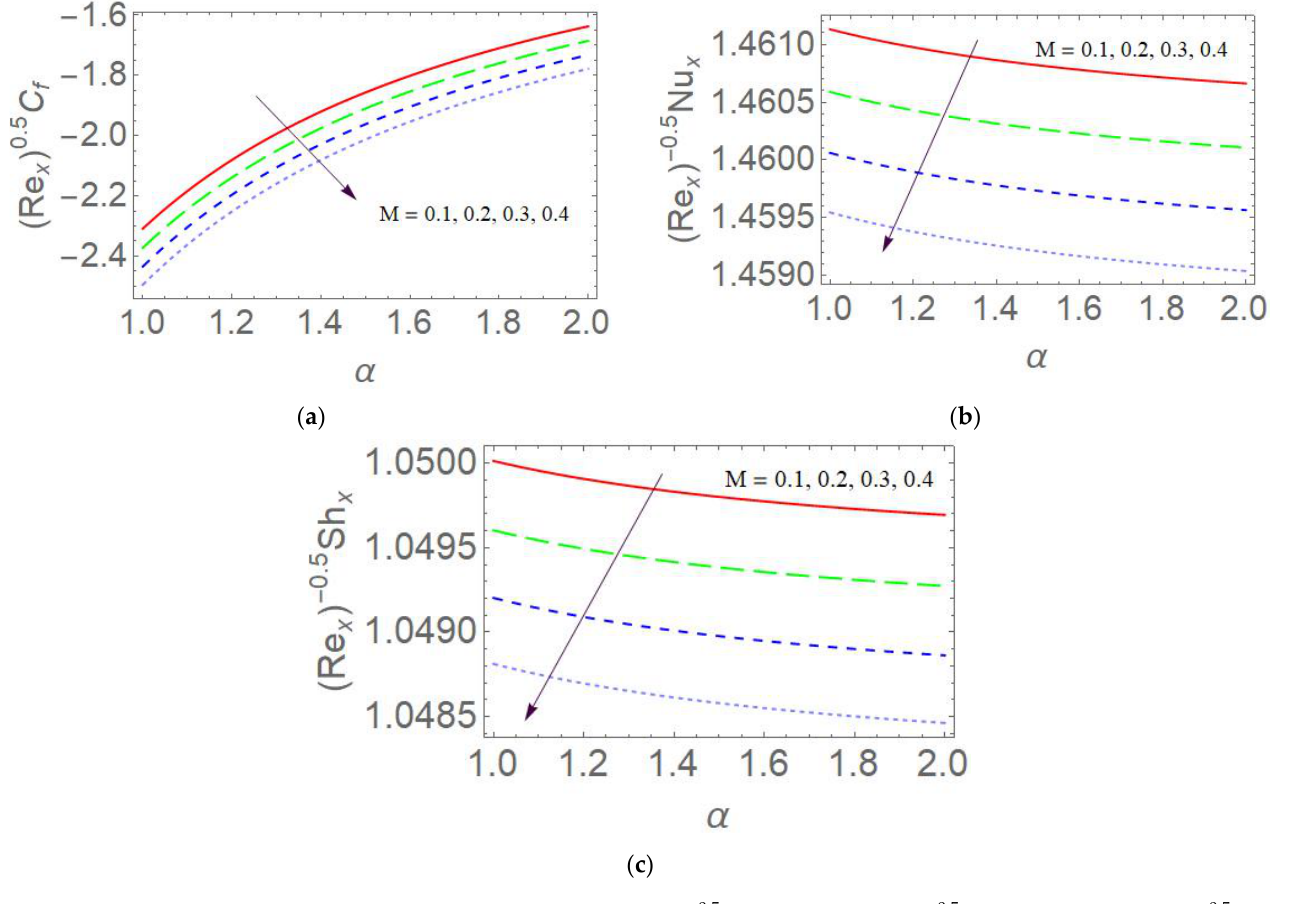
Figure 7. Influence of ( a ) M on C f ( Re x ) 0.5 , ( b ) M on Nu x ( Re x ) − 0.5 , and ( c ) M on Sh x ( Re x ) − 0.5 .